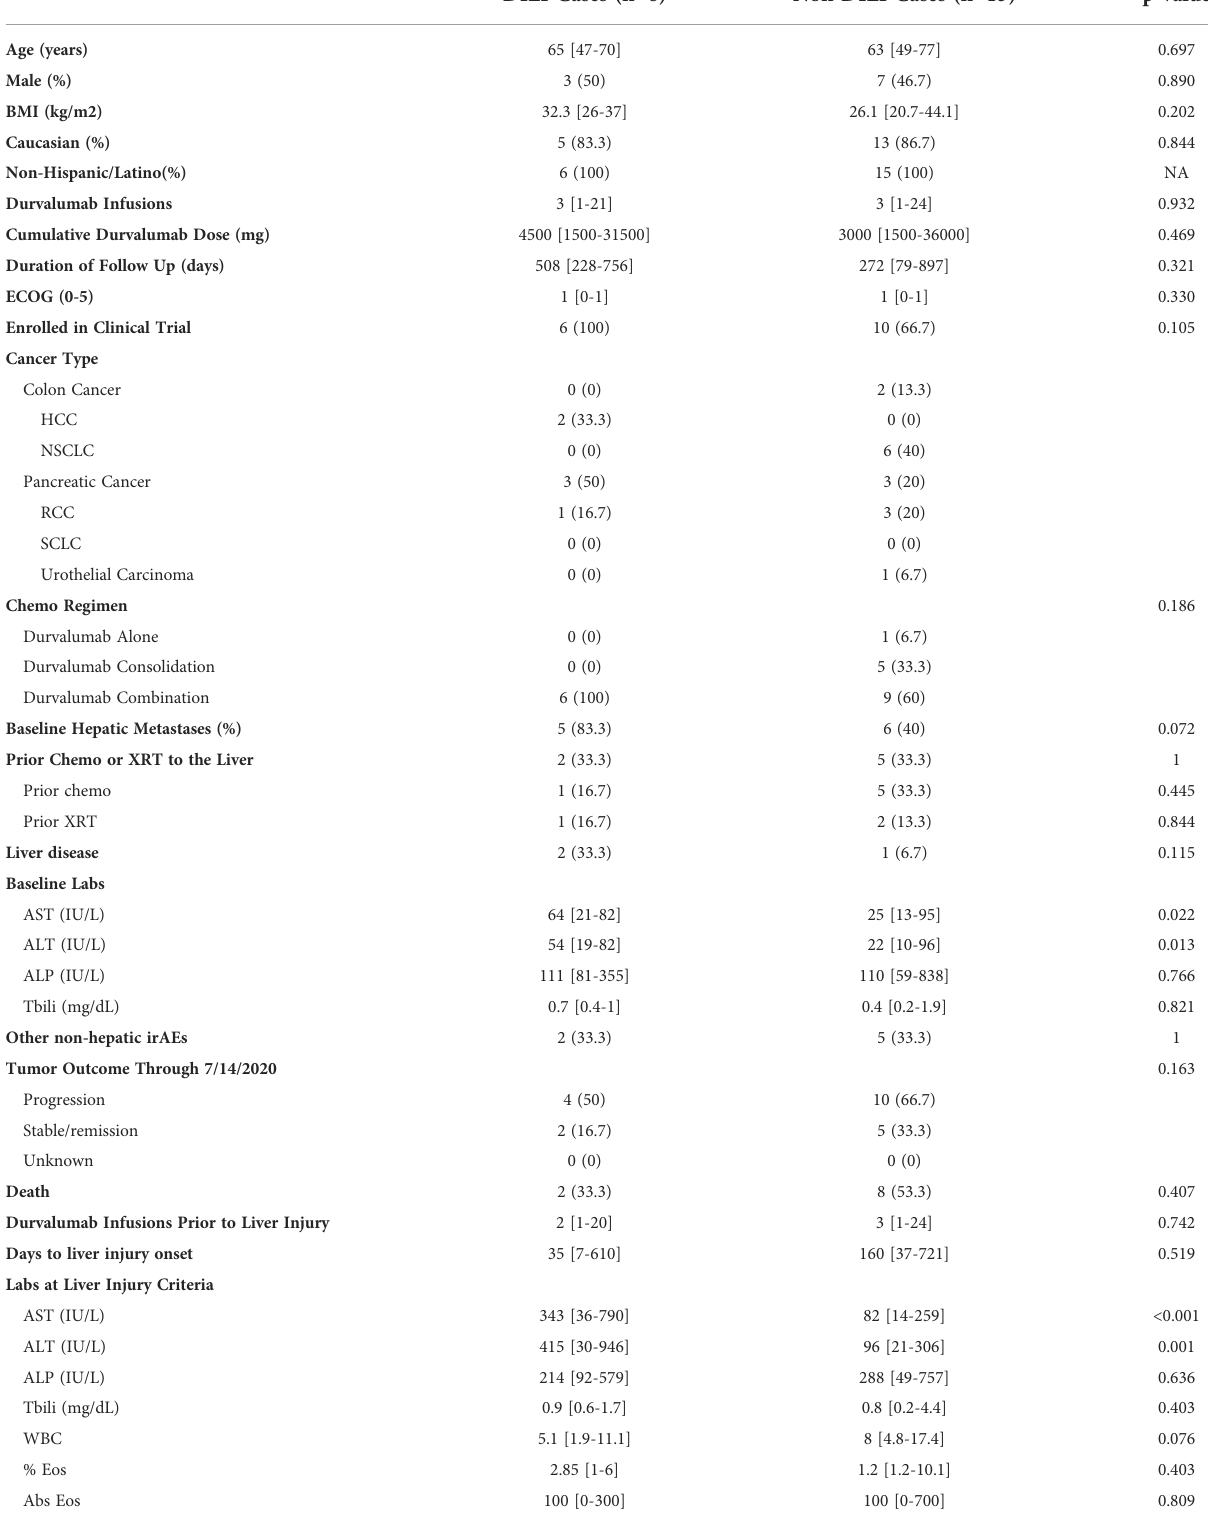
TABLE 2 Clinical characteristics of the 21 patients who developed liver injury on